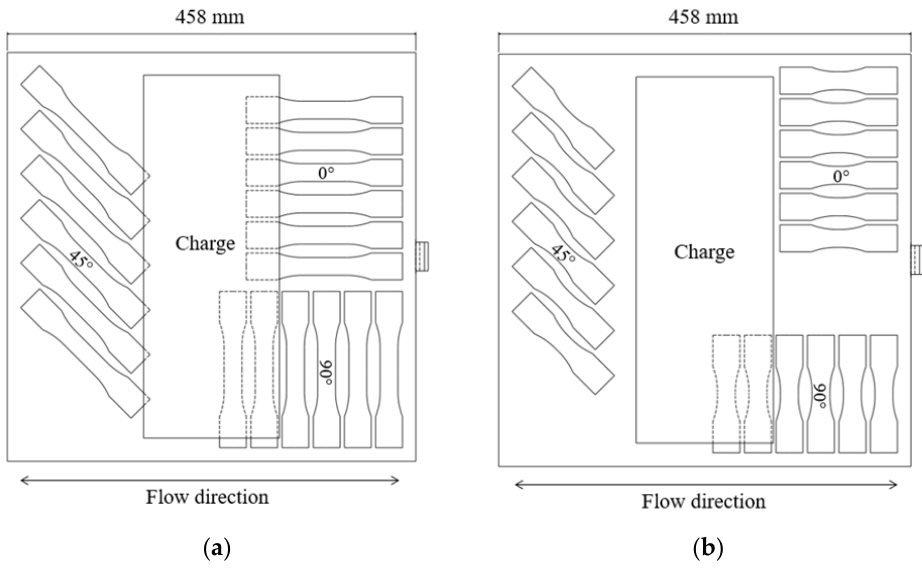
Figure 2. Specimen layouts ( a ) ASTM D638 Type III, ( b ) ASTM D638 Type III with reduced gauge length (6.25 mm shown).